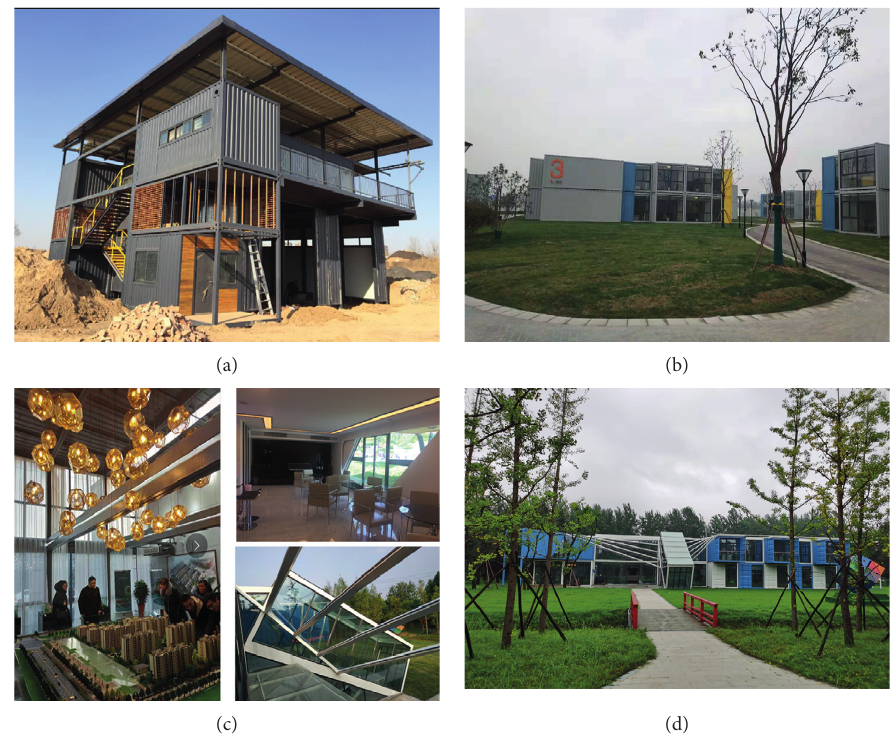
Figure 9: Finite element stress analysis on modules of a container